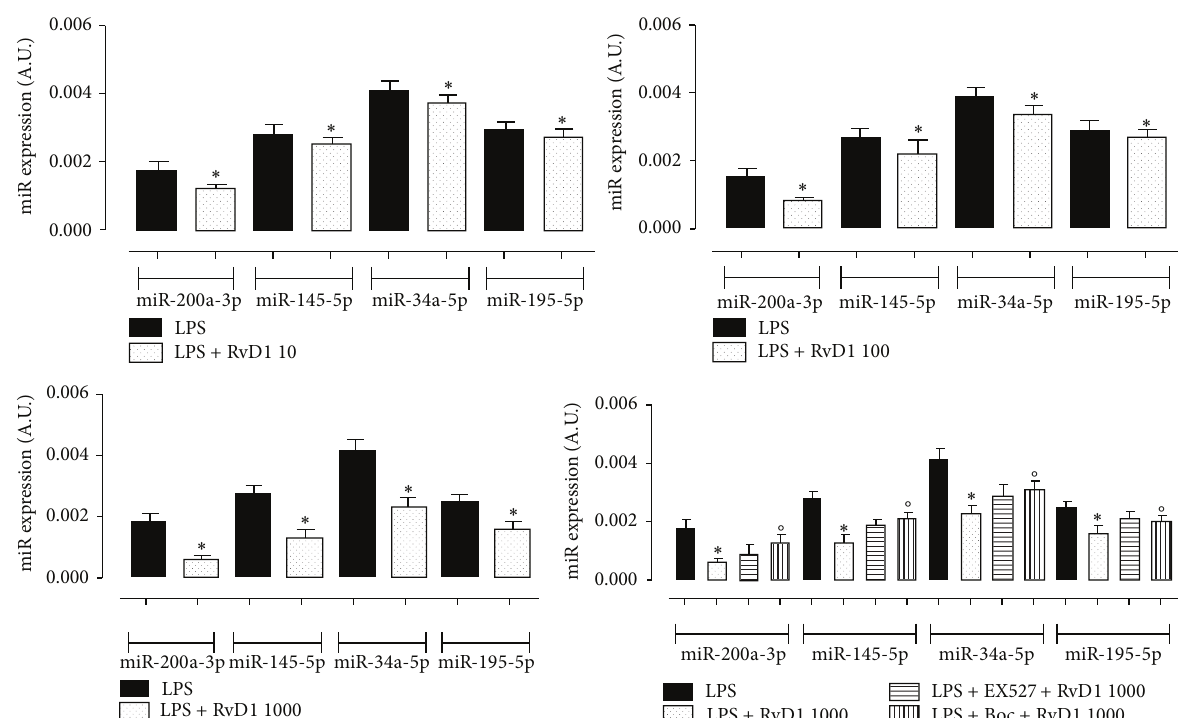
Figure 6: miRNAs expression (A.U., arbitrary units) in LPS-treated rats and LPS + RvD1 (10, 100, 1000 ng/kg) into the vitreous. Values are mean ± S.E.M. of 𝑛 = 6 observations for each group. ∗ 𝑃 < 0.05 and ∗∗ 𝑃 < 0.01 versus LPS-treated group, while differences versus LPS + RvD1 1000 ng/kg groups are shown as ∘ 𝑃 < 0.01 . Boc = Boc2; RvD1 = resolvin D1.